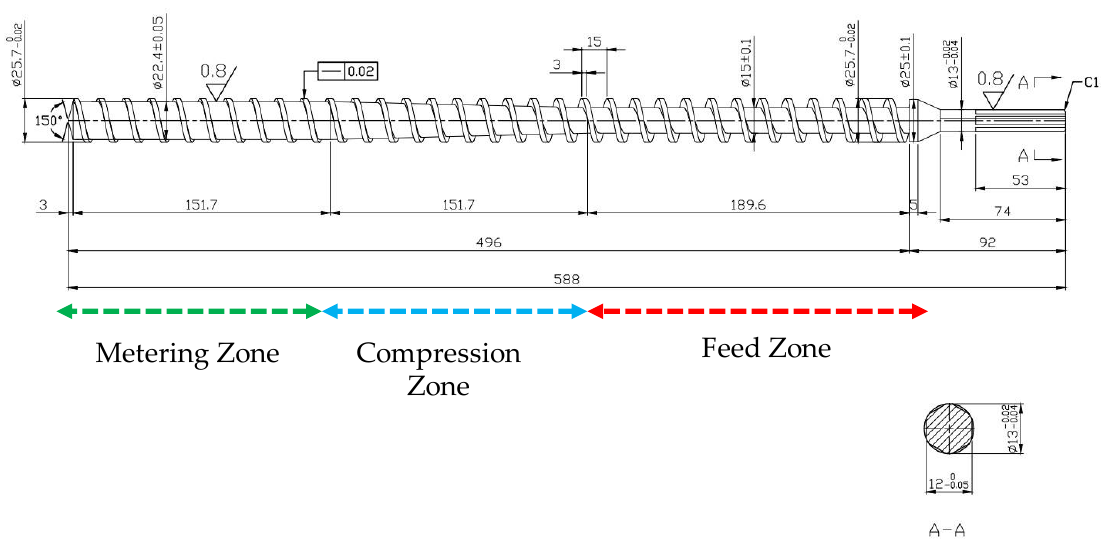
Figure 8. Diagram of single-flighted, stepped compression screw design and the mechanism zone.